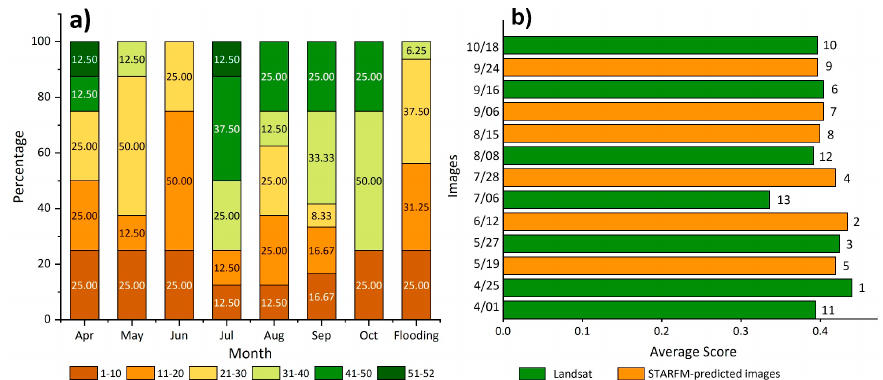
Figure 14. Contribution of different time windows and images to the classification. ( a ) Contribution of each month and the entire transplanting and flooding period to the classification through evaluating its feature importance. The top crucial features were colored in dark brown, while the least decisive features were shown in dark green. ( b ) Contribution of each image to the classification by calculating the average score of its feature importance. The rankings of importance for all images (in descending order) are